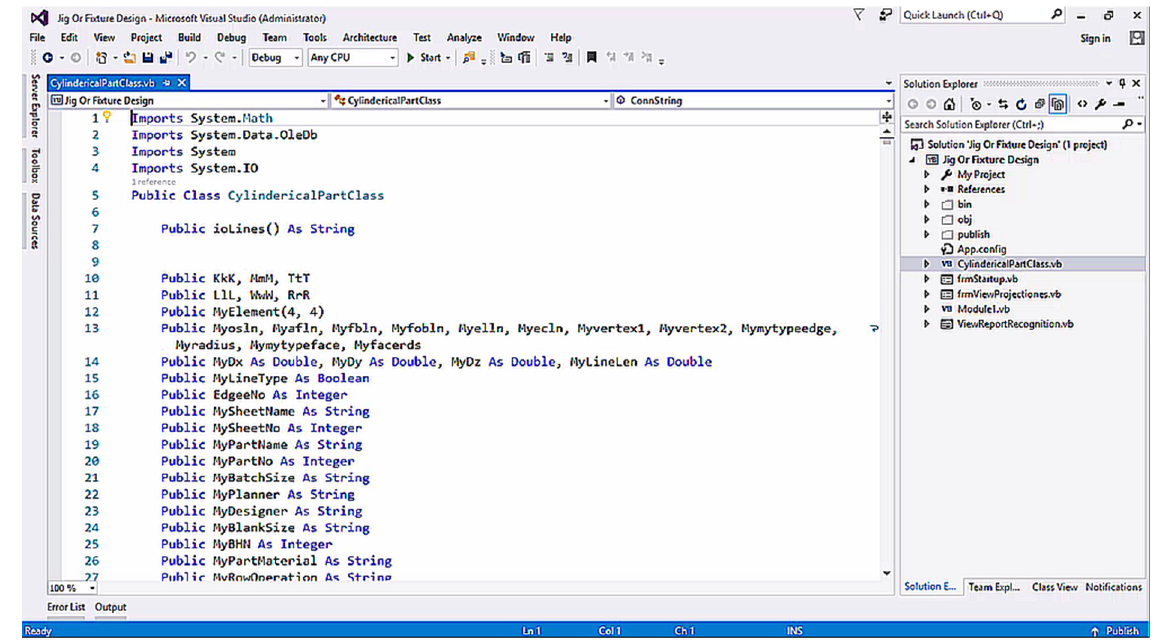
Figure 6. The main window of the developed system.